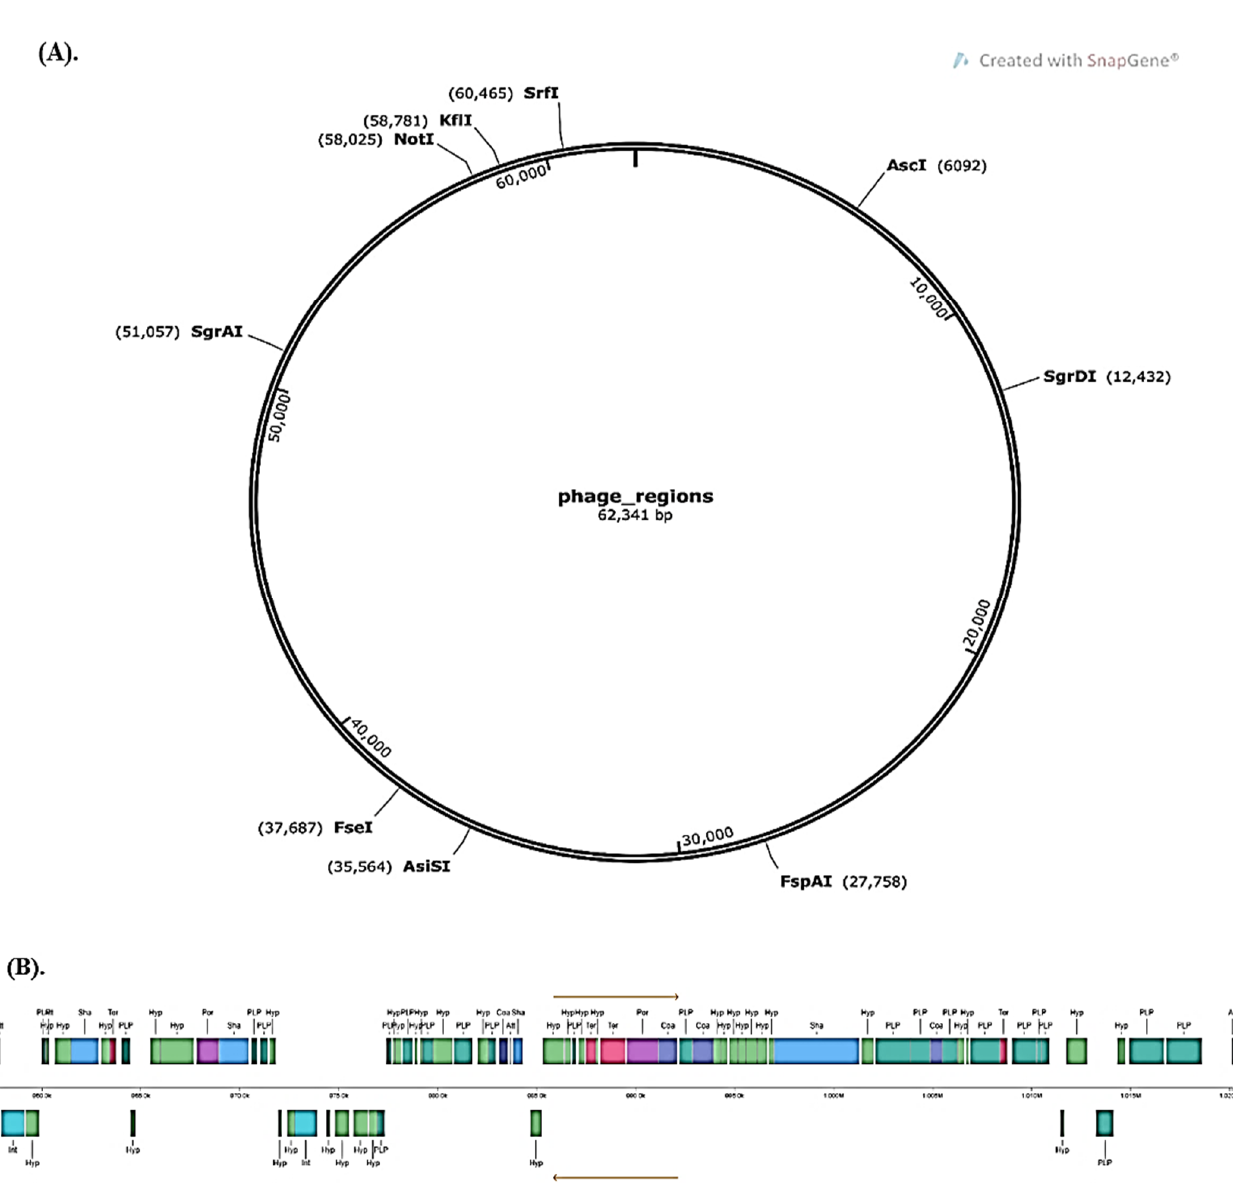
Figure 2. PHASTER’s prediction of phage sites ( A ) Complete genome prediction of Lp YW11 with phage areas in the lactoplantibacillus plantarum genome ( B ) Expanded view of the genome with phage